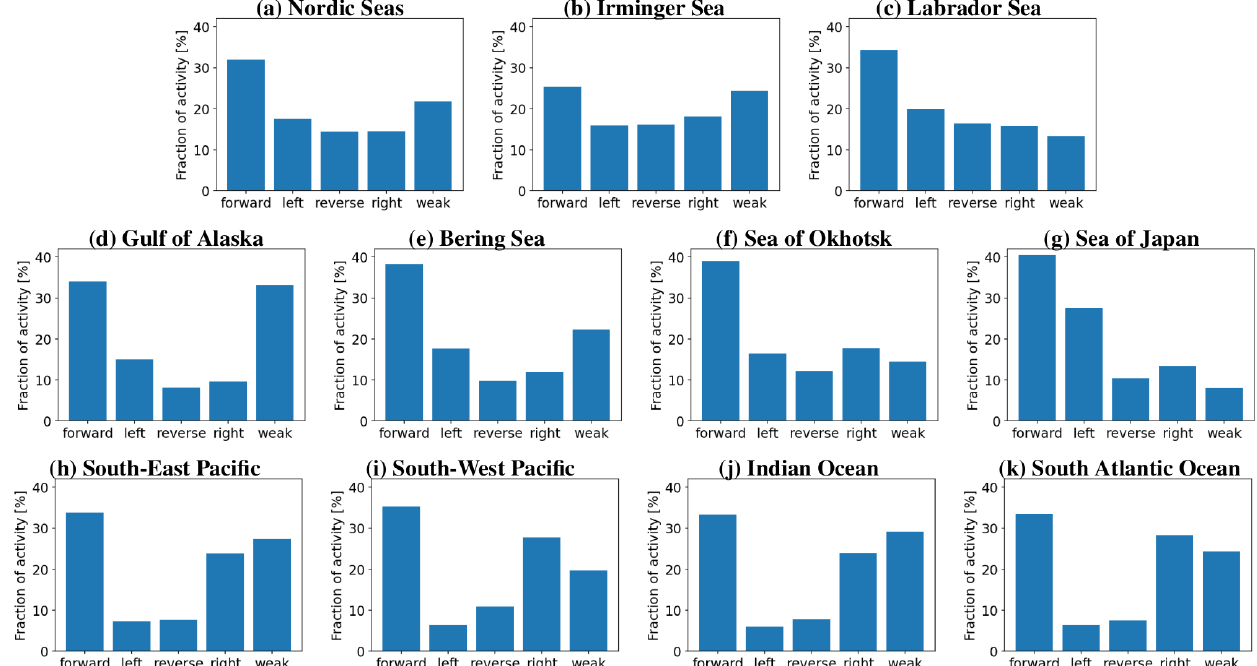
Figure 9. Distribution of the different shear categories in the regions marked by boxes in Fig.